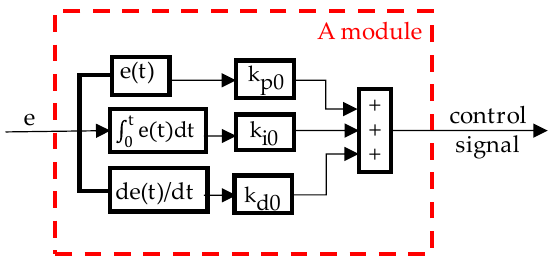
Figure 2. Block diagram of the speed control using traditional PID controller.